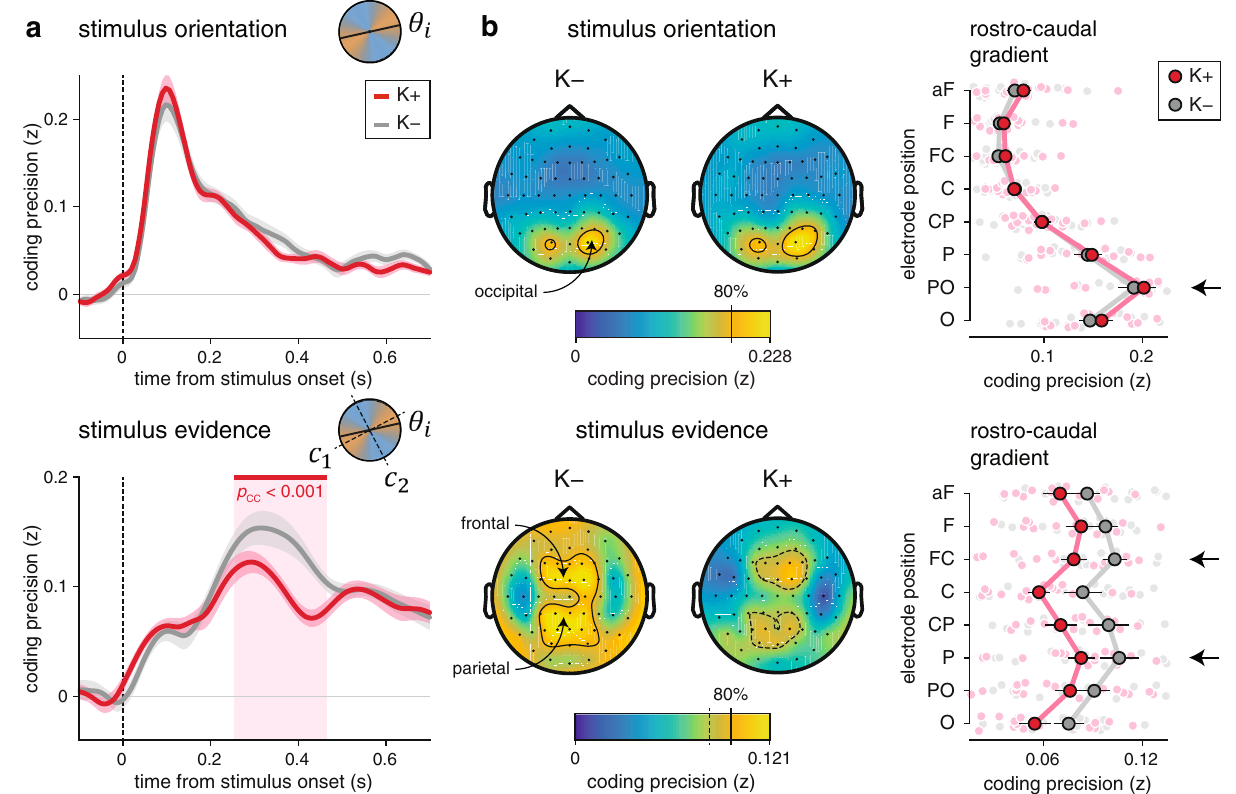
Fig. 4 Degraded neural processing of evidence under ketamine. a Time course of the neural coding of stimulus characteristics by EEG signals (top: stimulus orientation; bottom: stimulus evidence). Lines and shaded error bars indicate group-level means ± s.e.m. ( N = 18 participants). The neural coding of orientation is preserved under ketamine, whereas the neural coding of evidence is degraded from 250 to 450 ms following stimulus onset. The red- shaded area indicates the signi fi cant difference in coding precision between conditions (two-sided t tests corrected for multiple comparisons across time). b Spatial topography of the neural coding of stimulus characteristics (top: stimulus orientation; bottom: stimulus evidence). Left: channel-wise coding precision, obtained by averaging neural predictions over time (stimulus orientation: 50 – 150 ms; stimulus evidence: 250 – 450 ms). Contours delineate channels with a coding precision larger than 80% of the overall peak. Right: coding precision along a rostro-caudal gradient, from occipital (O) to anterior frontal (aF) channels. Large dots and error bars indicate group-level means ± s.e.m., whereas small dots indicate participant-level data ( N = 18 participants). The neural coding of orientation relies on occipital channels, whereas the neural coding of evidence peaks at parietal and frontal channels (black arrows). Source data are provided as a Source Data fi